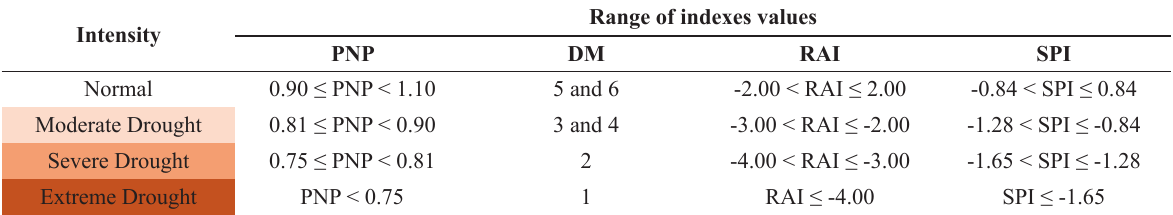
Drought intensity classification based on the PNP, DM, RAI and SPI indices and class limits proposed and adopted in the present study.